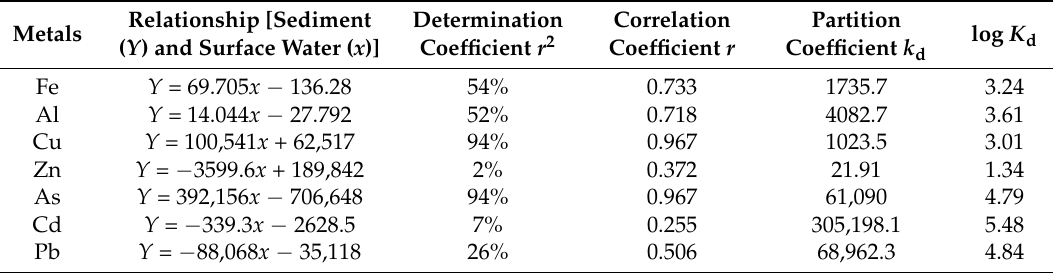
Figure 3. Metal pollution index (MPI) of sediment for each sampling station. Table 4. Various relationships of the metals in the